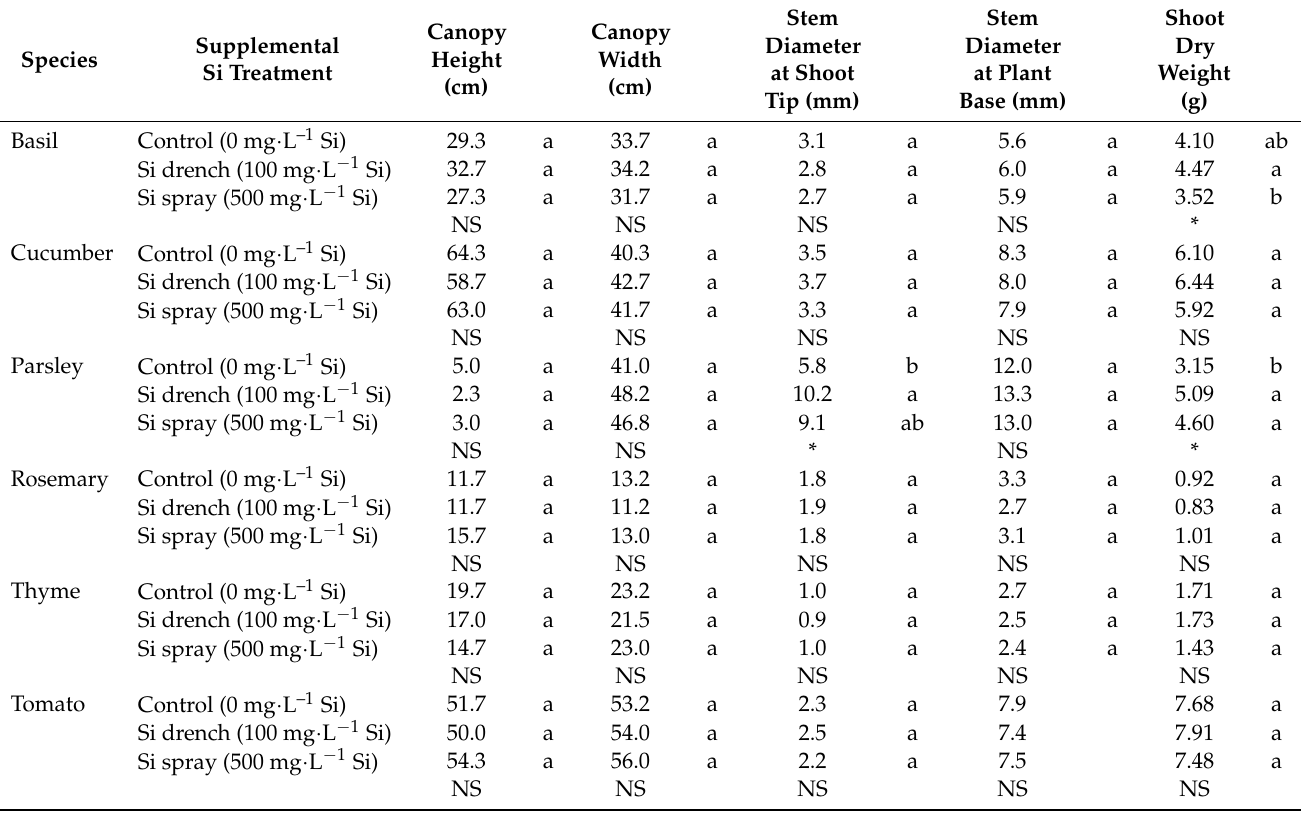
Table 3. Effects of supplemental silicon (Si) treatments on canopy height and width, stem diameter at the shoot tip and base of the plant, and shoot dry weight measured at the end of production for six container-grown edible species. Silicon foliar sprays and substrate drench treatments were applied every 7 days during production.